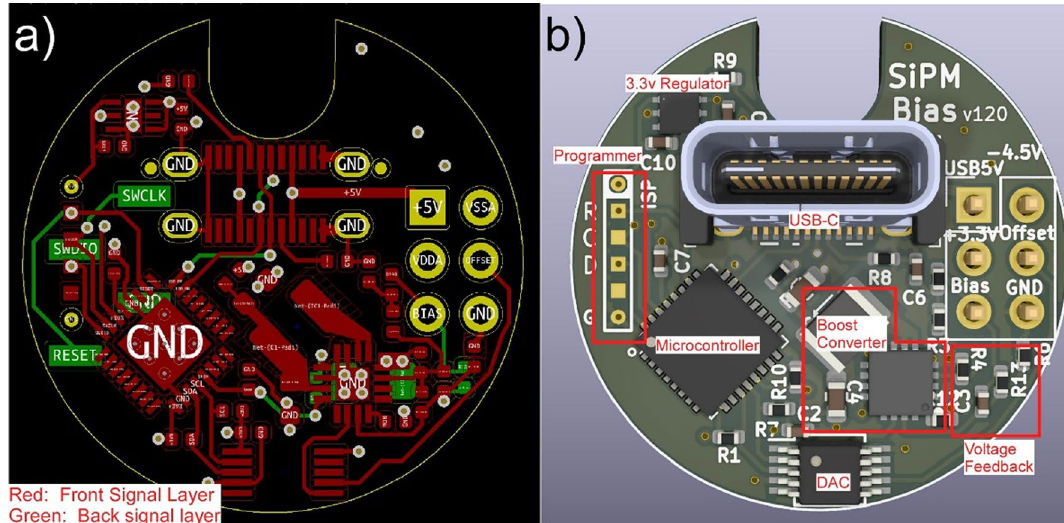
Figure 3. SiPM bias generator design. ( a ) Top (red) and bottom (green) signal layers for the bias generator PCB. Additional power and ground layers (internal) consisting of simple copper planes are omitted. ( b ) Assembled board with annotated functional components. A USB-C connector provides +5 V power, which is regulated down to 3.3 V for use by a microcontroller, which also provides the USB interface. A multichannel DAC is used to set the reference voltage for both the boost converter and the attached transimpedance amplifier.